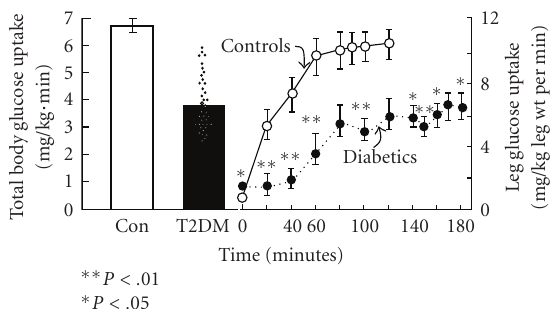
Figure 2: Insulin-stimulated whole body glucose uptake measured with the euglycemic clamp in lean healthy and type 2 diabetic subjects (left) and time course of change in leg glucose uptake in type 2 diabetic and control subjects (right) (from [5]).